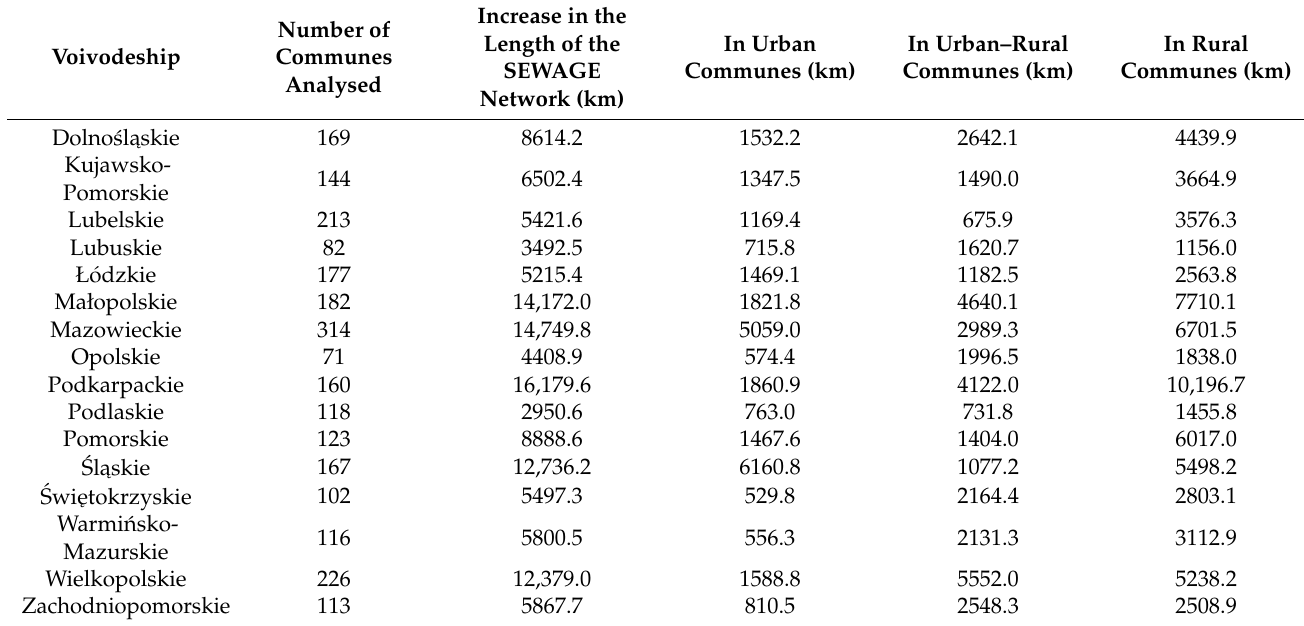
Table 1. Increases in the length of the sewage network in the Polish communes in